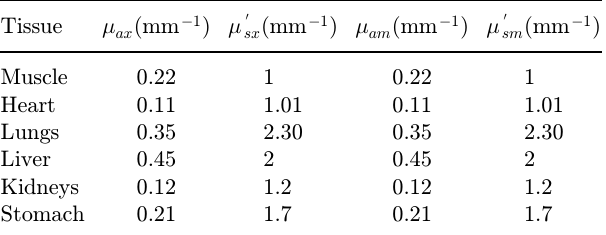
Table 4. Optical parameters of the mouse organs (highly absorbing media). Tissue